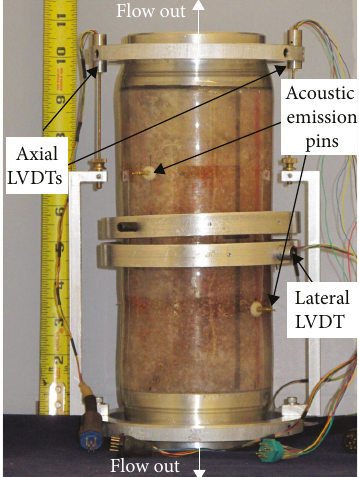
Figure 2: Typical sample assembly showing locations of LVDTs, acoustic emission pins, and noble gas fl ow